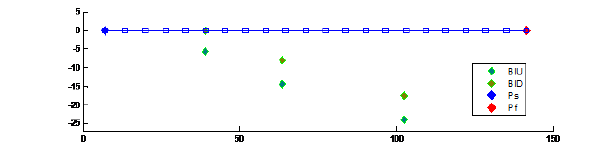
Fig. 5 The upper and lower initial limits of the population shown on the horizontal